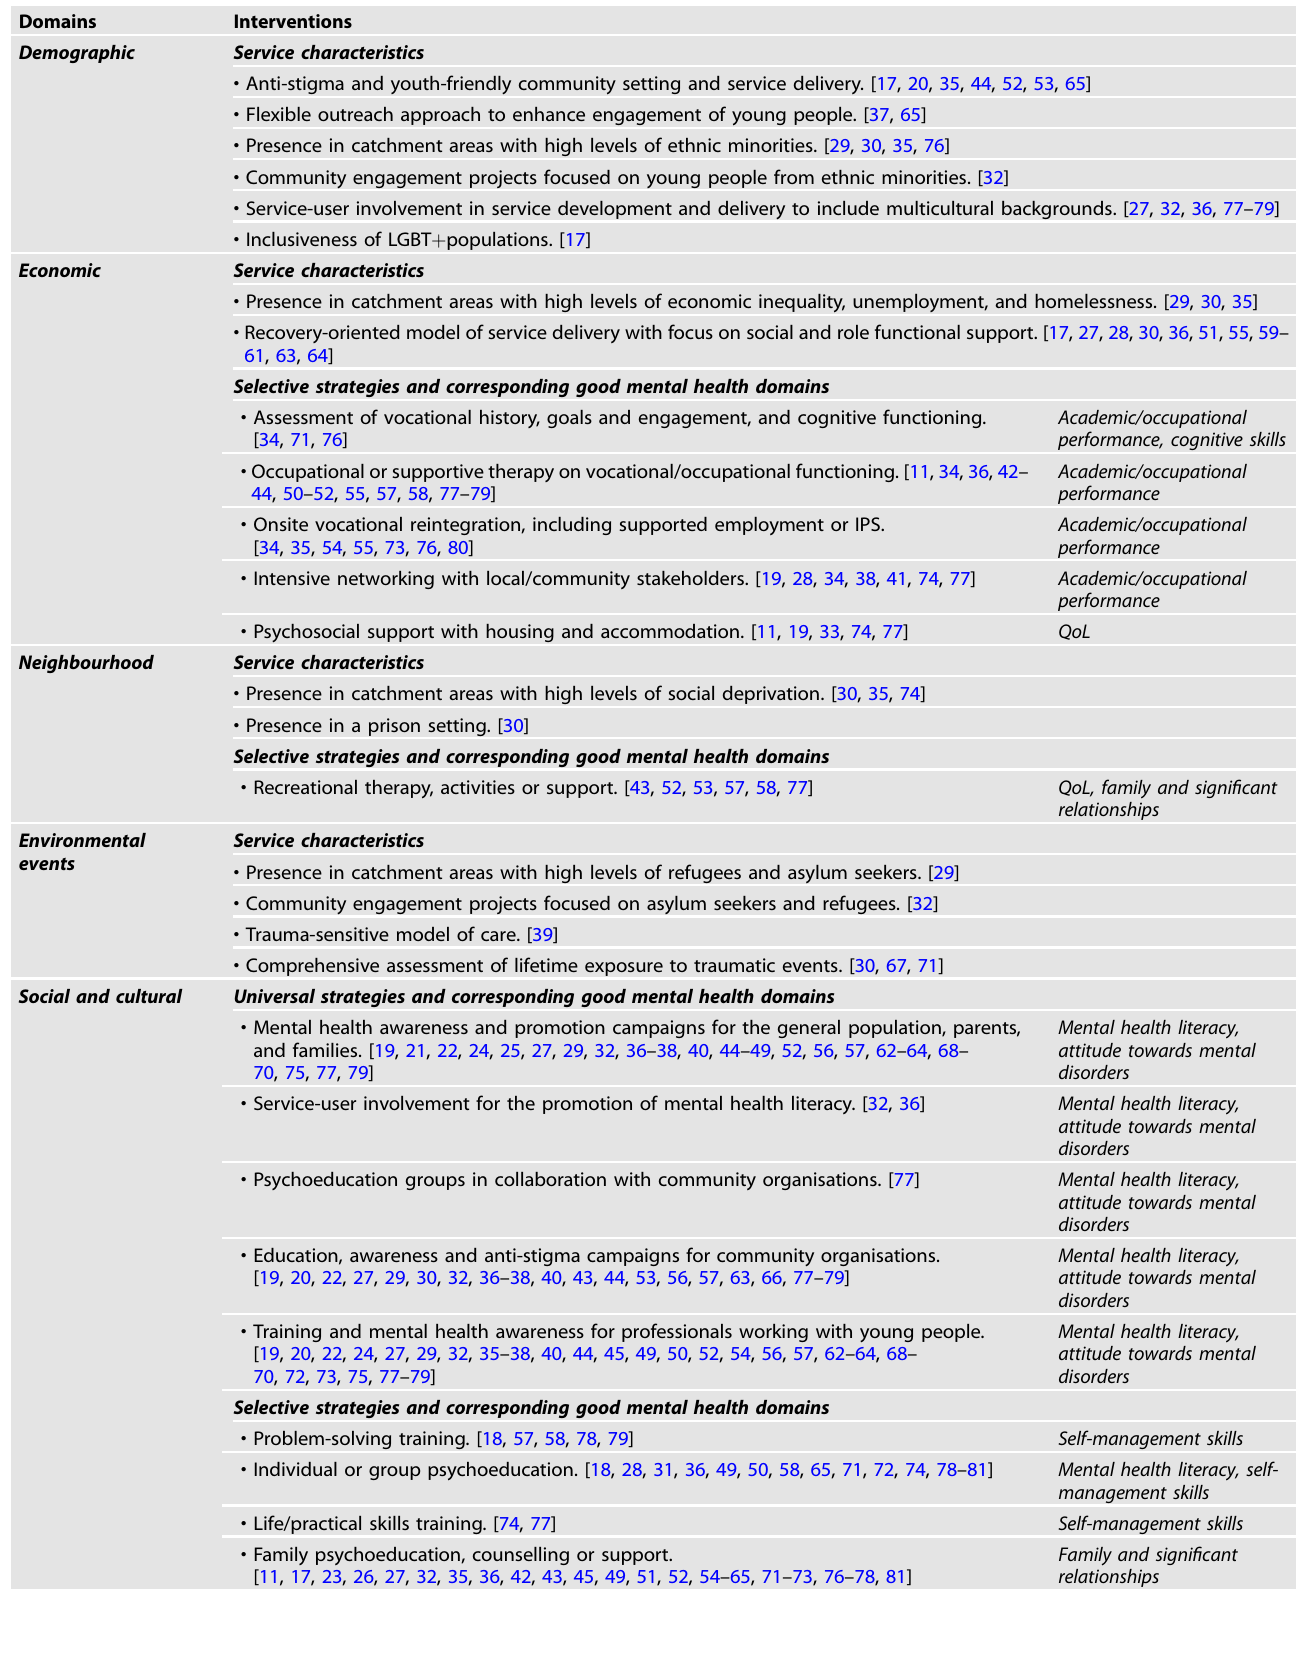
Table 3. Public health strategies delivered by CHR-P services targeting the social determinants of mental disorders, strati fi ed by service characteristics, universal strategies, selective strategies, with the corresponding good mental health